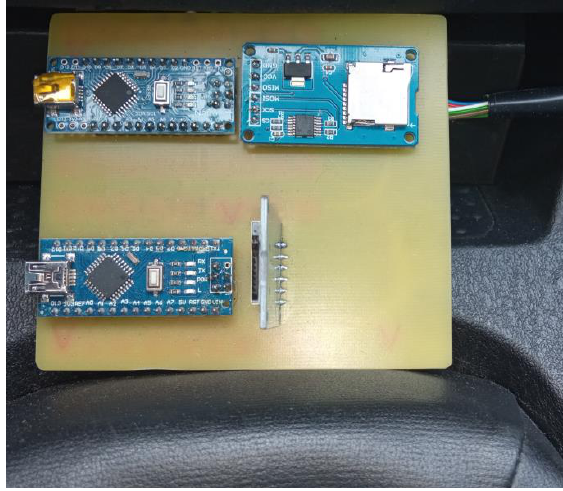
Fig. 9. Measuring systems of slowly-changing parameters were installed in a Mitsubishi Carisma GDI